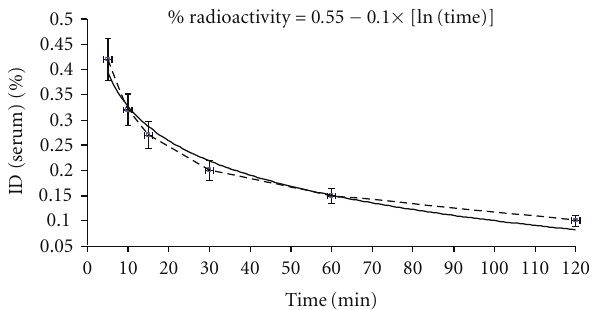
Figure 3: Blood clearance of the 99m Tc-autoalbumin in study animals ( n =